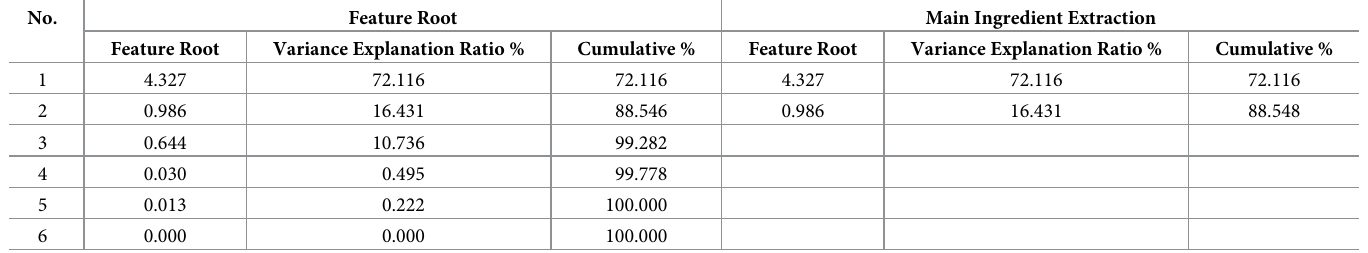
Table 3. Explanation of